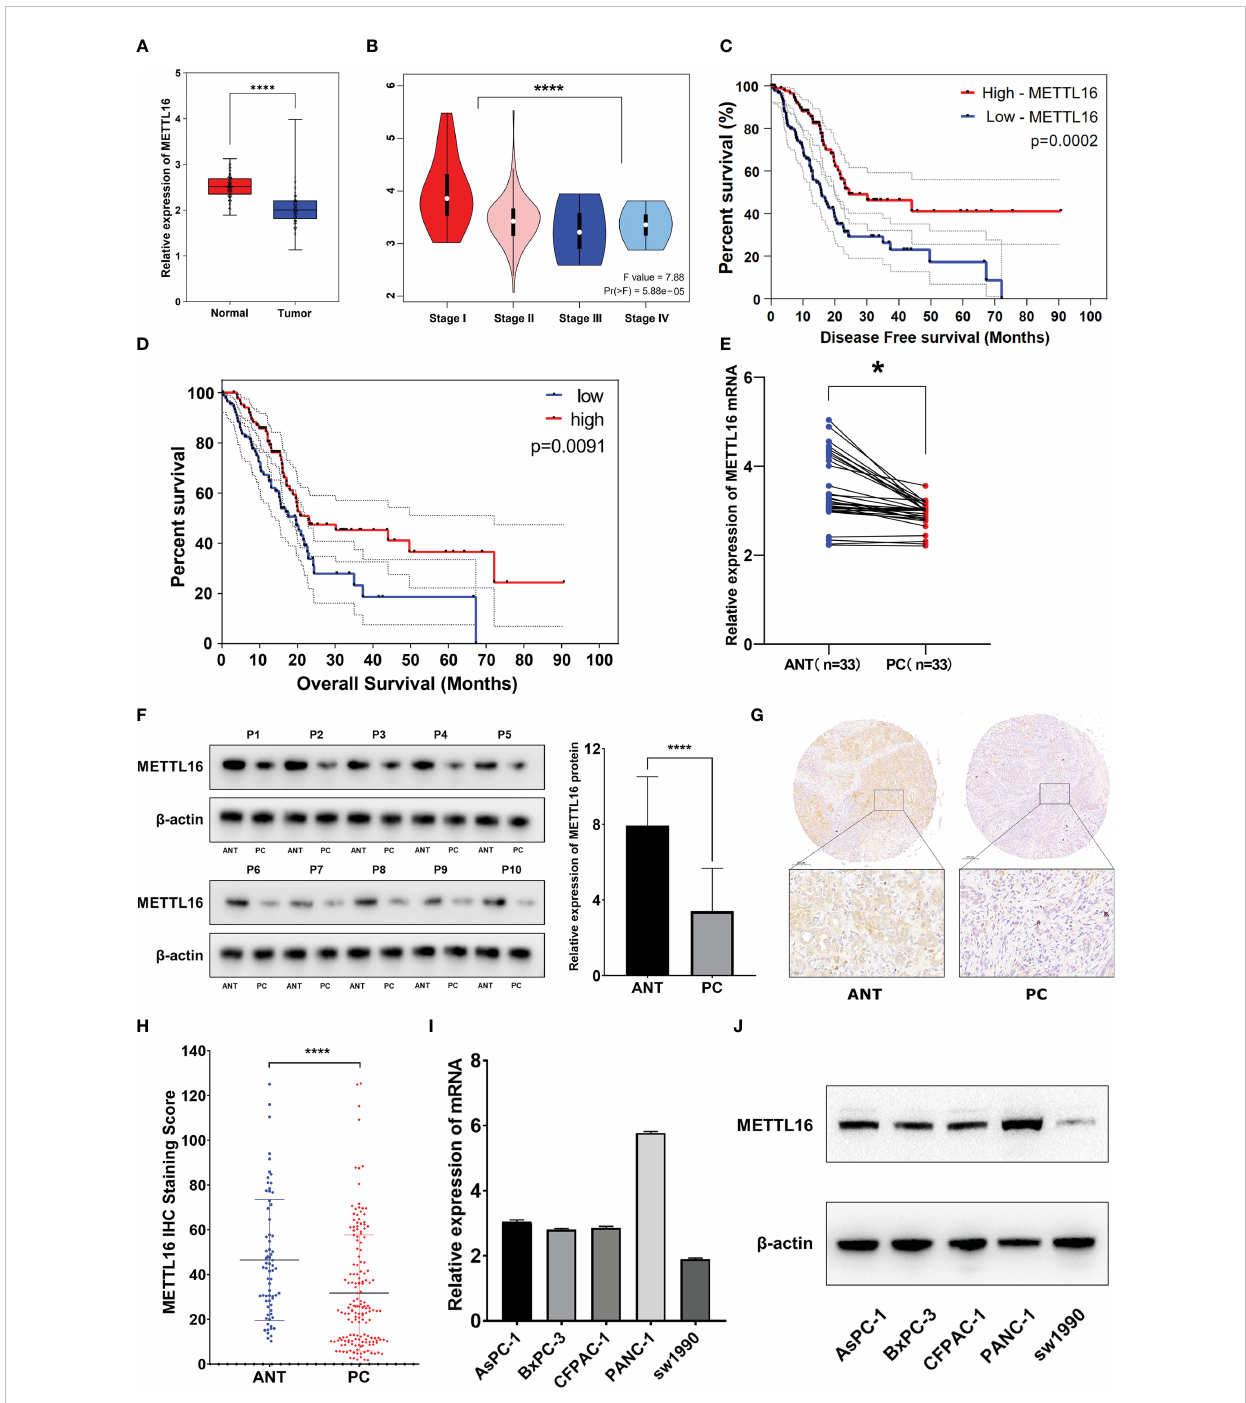
FIGURE 1 METTL16 is downregulated in PDAC tissues, and downregulation of METTL16 suggests poor prognosis. (A) The mRNA level of METTL16 in normal tissues and PC tissues in data downloaded from The Cancer Genome Atlas (TCGA) and GTEx database (p < 0.001). (B) mRNA level of METTL16 in different PC stages (I ‐ IV) according to data downloaded from the TCGA database (p < 0.05). Cox regression multivariate analysis showed that the expression level of METTL16 was signi fi cantly positively correlated with both the DFS (C) and OS (D) from TCGA. (E) METTL16 expression was assessed by qRT − PCR in paired PC tissues and ANTs (N = 33). (F) Western blotting was performed to detect the protein level of METTL16 in 10 PC tissues and paired ANTs. (G) METTL16 expression was assessed by IHC in PC tissue microarrays and two independent clinical (N = 133) and ANT (N = 133) sample cohorts. (H) The METTL16 staining score in adjacent non-cancerous tissue was signi fi cantly higher than that in PC tissues. (I) mRNA levels of METTL16 in 5 PC cell lines (AsPC-1, BxPC-3, CFPAC-1, PANC-1, and SW1990). (J) Protein level of METTL16 in 5 PC cell lines. * means p<0.05; **** means